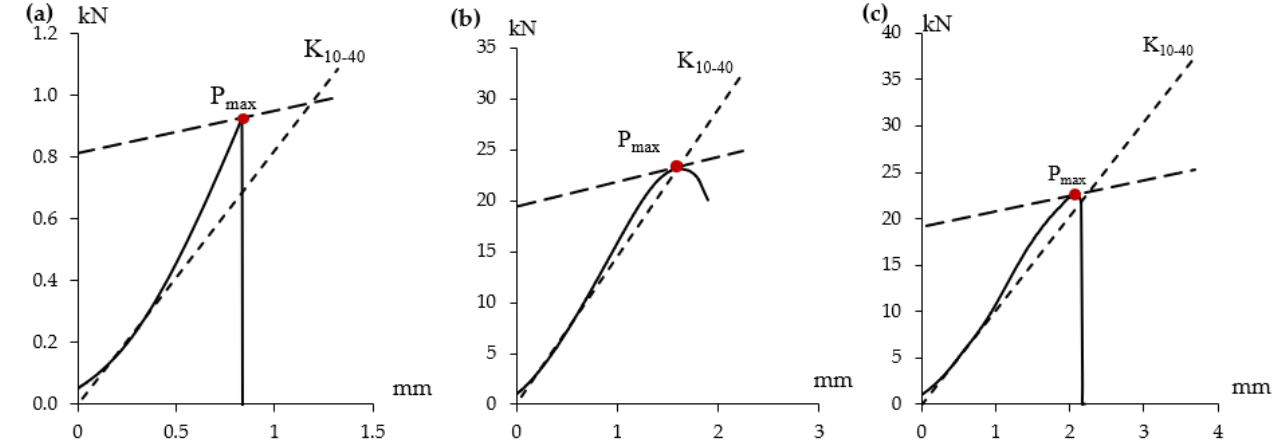
Figure 10. Examples the failure of K 10–40 line that located offsite the load-displacement curve in ( a ) tension, ( b ) compression parallel-to-fiber, and ( c ) shear tests.